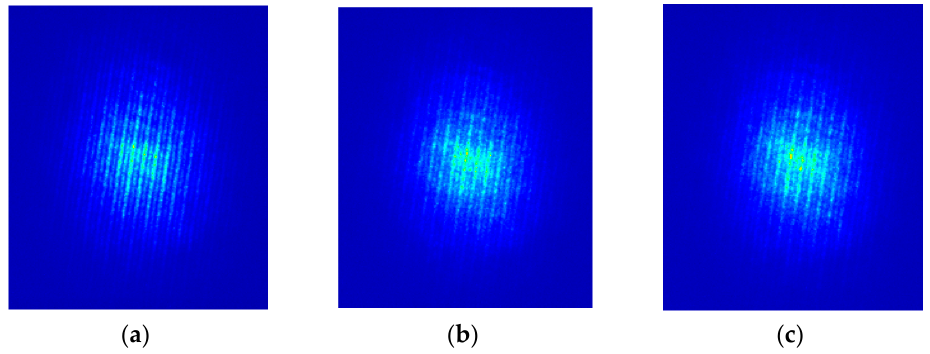
Figure 5. Images of interference fringes. ( a ) Continuous laser; ( b ) each way with 200 MHz communication; ( c ) each way with 500 MHz communication.